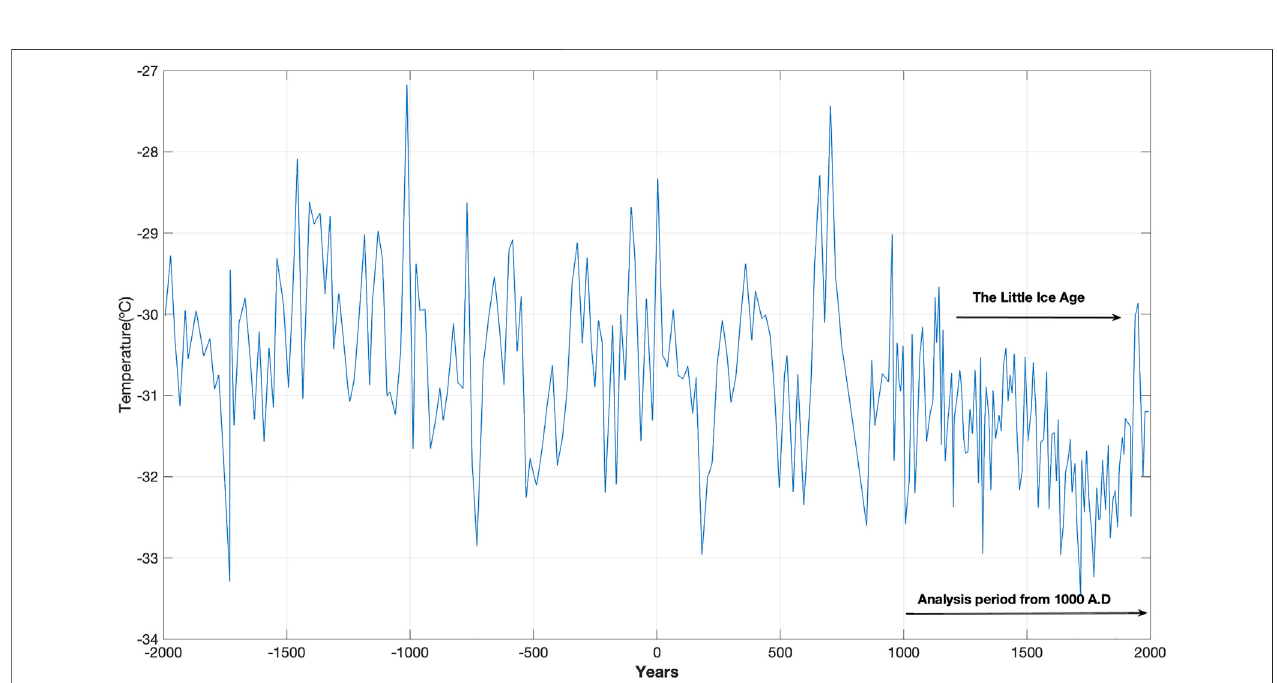
FIGURE 7 | Greenland temperature (GISP2) time series spanning t = ( − 2000 ... 1993) (yr.) and from t = (1000 ... 1993) (yr.). “ The Little Ice Age ” is shown from approximately t = (1200 ... 1850) (yr.).